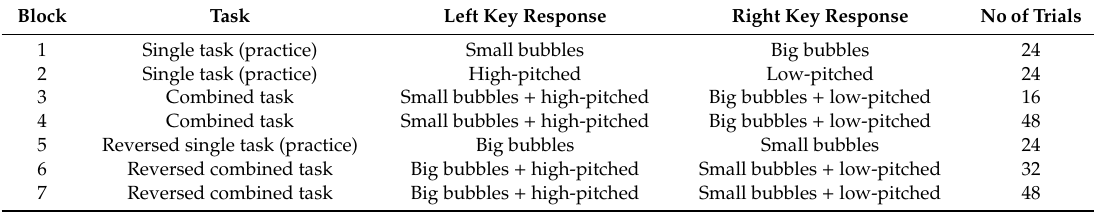
Table 1. Summary of the design for the Implicit Association Test (IAT)